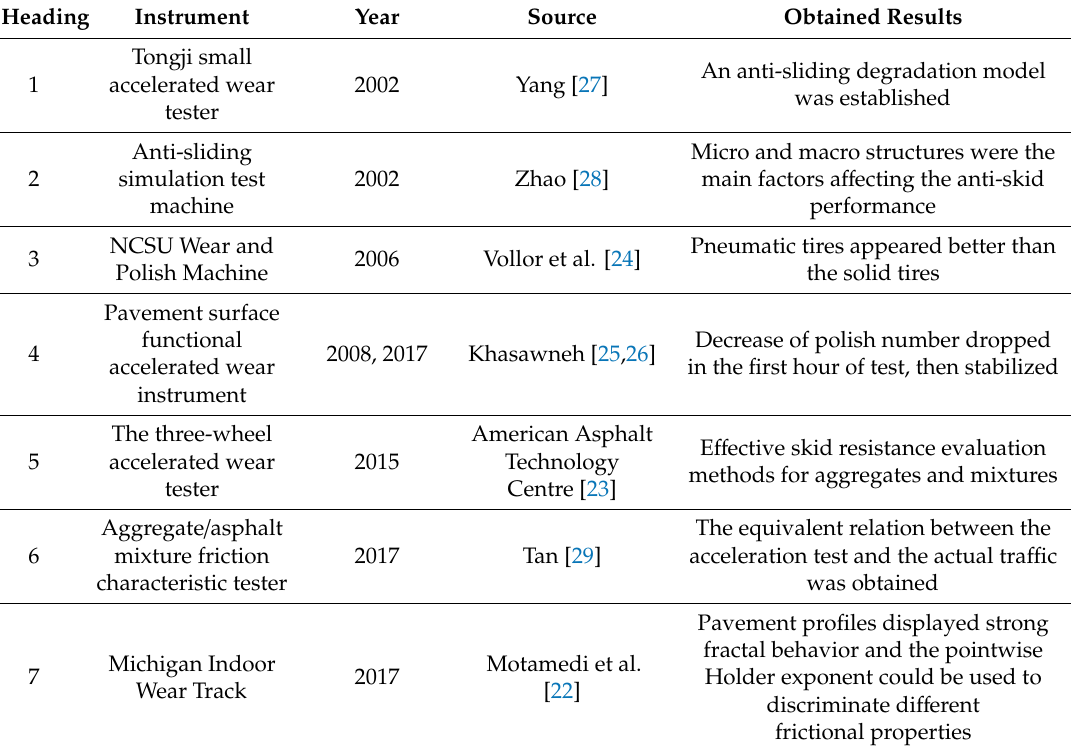
Table 1. List of instruments for pavement surface function